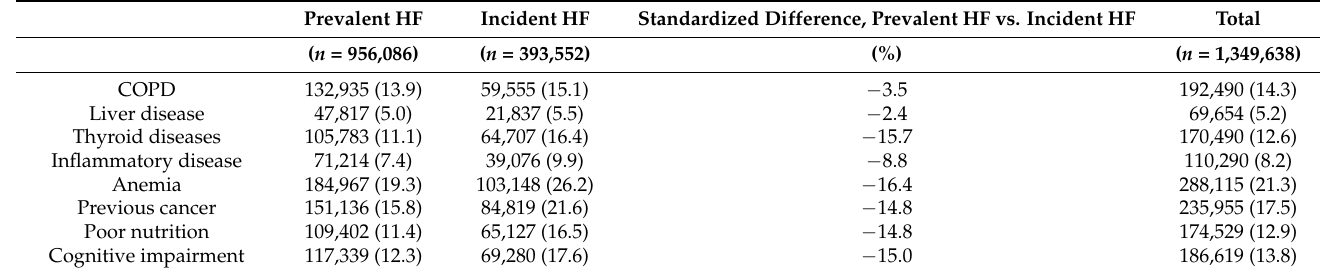
Figure 2. Standardized percentages of bias across main baseline characteristics in unmatched and matched patients with AF and HF, with incident HF and prevalent HF.